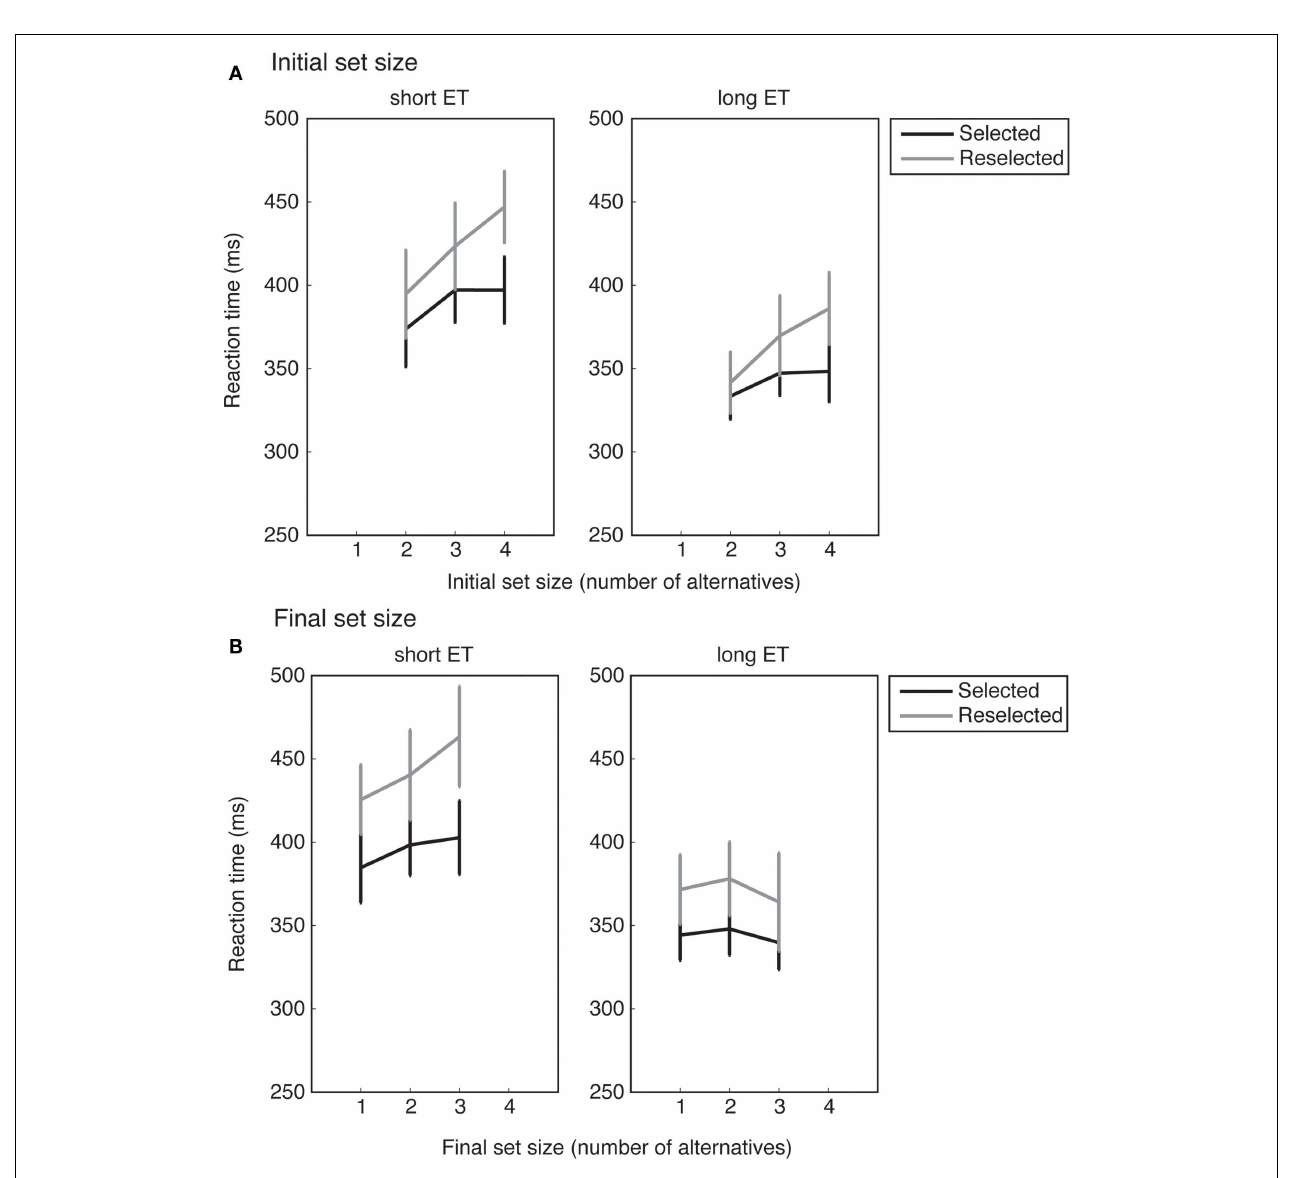
monotonically with the initial response set size, but not with the final response set sizes. Error bars show standard error of the